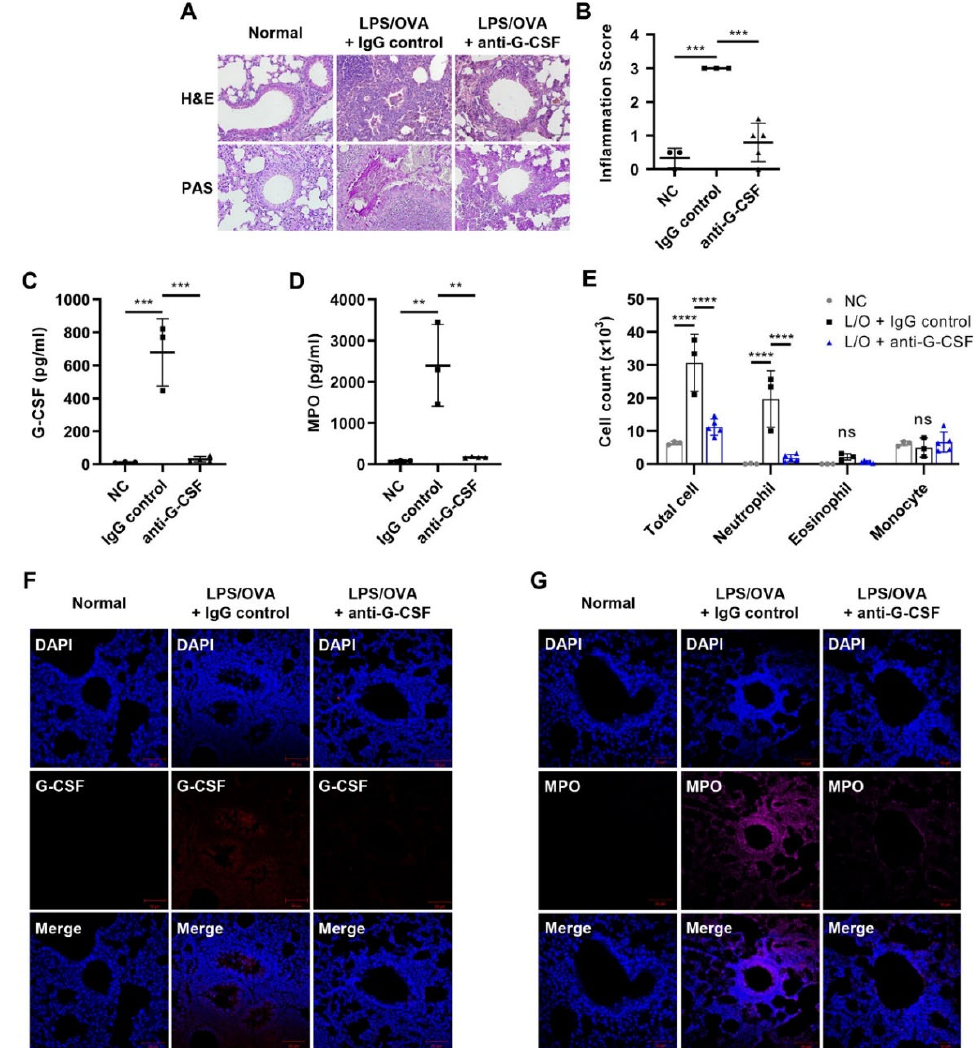
Figure 2. G-CSF is critical for neutrophilic airway inflammation. For the analysis of the effect of anti-G-CSF, mice were administered anti-G-CSF (5 mg/kg) or control IgG1 (5 mg/kg) by i.p. injection 1 h before each challenge ( n = 3–5 per group). The negative controls (NC) were untreated. ( A , B ) H&E and PAS staining of mice lung tissues. Perivascular and peribronchial inflammation, in addition to mucus secretion, was examined and scored (400 × ). Inflammation scores are shown as the mean ± SD ( n = 3–5 per group). ( C , D ) G-CSF and MPO levels in BALF were analyzed by ELISA. ( E ) The number of immune cells in BALF was estimated using a CytoSpin and staining with Diff-Quik. The results are shown as the mean ± SD ( n = 3–5 per group). ( F , G ) IF staining of mouse lung tissues for G-CSF (red, Alexa Flour 647) and MPO (magenta, Alexa Flour 594). The nuclei were counterstained with DAPI (blue; 400×). The IF images are representatives of three independent trials with similar results. All experiments were performed in triplicate. ** p < 0.01, *** p < 0.001, **** p < 0.0001, ns: not significant versus each control group.